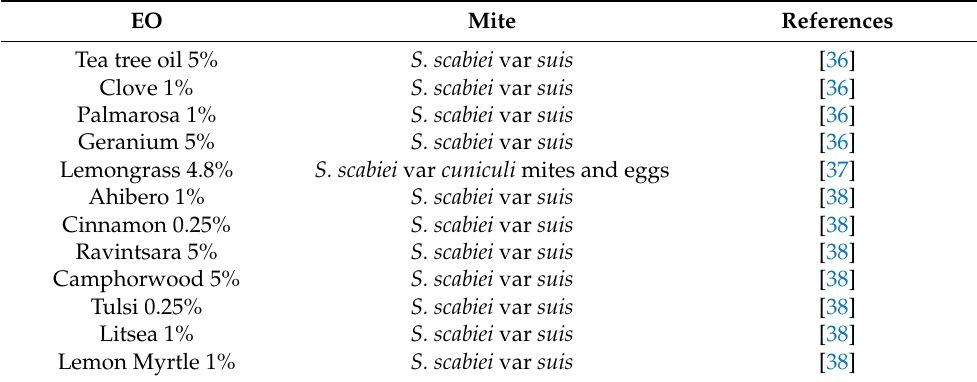
Table 1. Essential oils (EOs) active up to